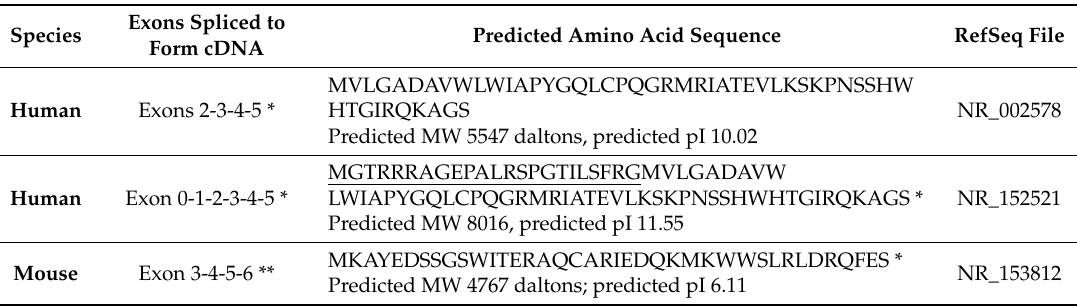
Table 3. Conceptual translation of small open reading frames (smORFs) in rodents and primates, with molecular weights (MW) and isoelectric points (pI) for each smORF’s predicted translation